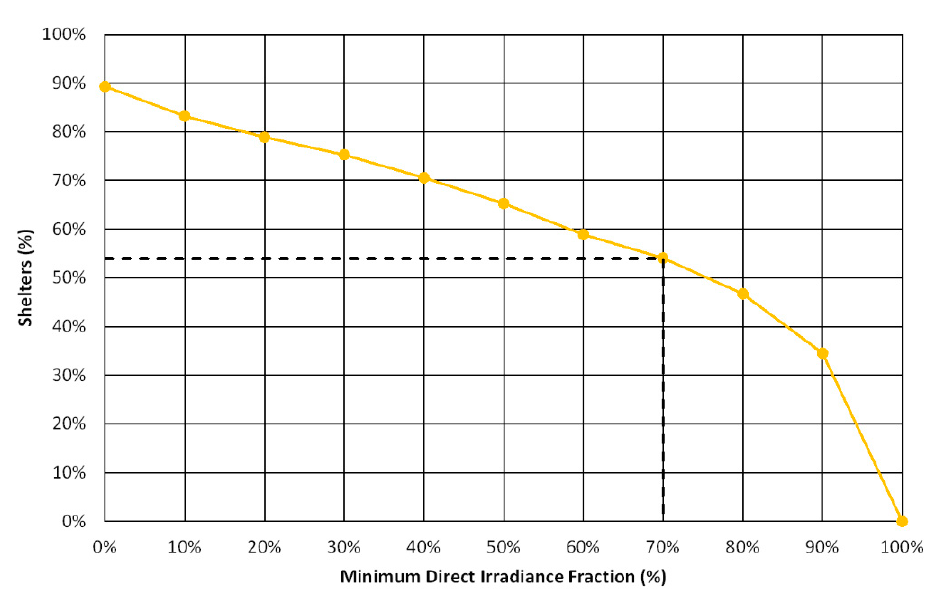
Figure 7. The fraction of bus shelters as a function of a minimum Direct Irradiance Fraction.